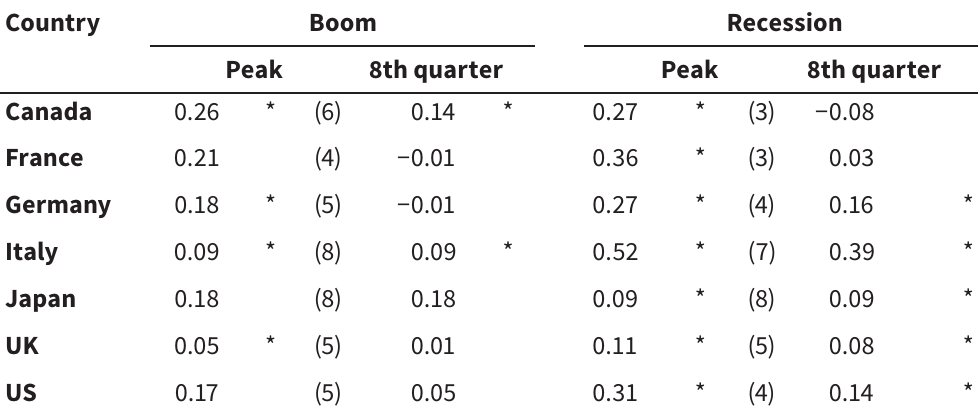
Effects of government spending shock on gender employment (Changes in the female share of total employment, in percentage points) Country